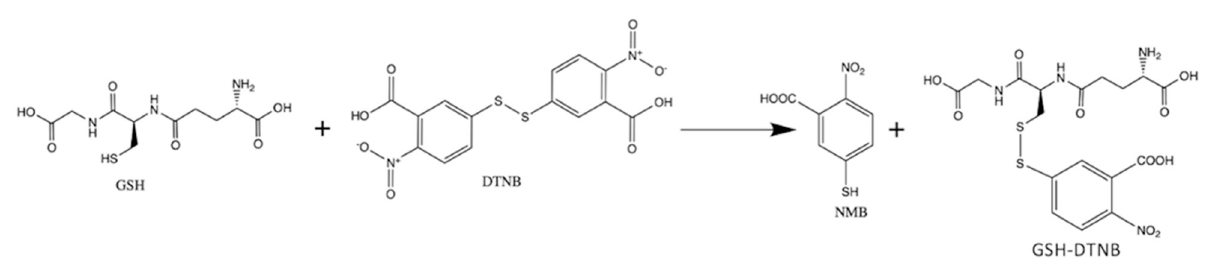
Figure 1. Reaction of Glutathione (GSH) with Ellman’s reagent/ DTNB (5,5 ′ -dithio-bis-(2-nitrobenzoic acid)); 2-Nitro-5- mercapto-benzoic acid (NMB).